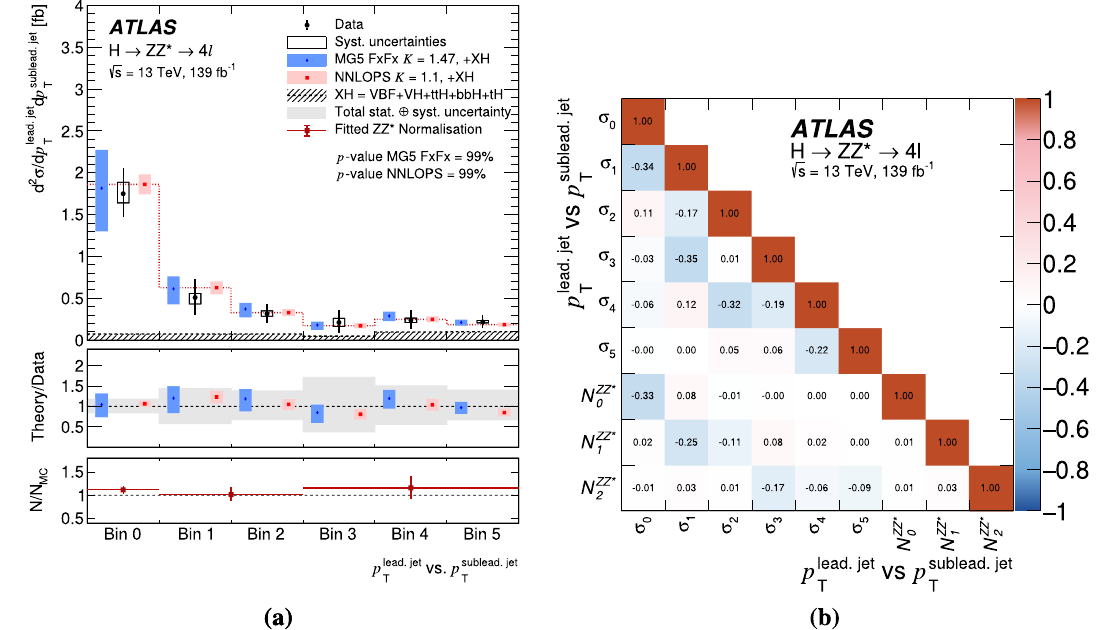
b thecorrespondingcorrelationmatrixbetweenthemeasuredcrosssec- . jet . jet tions and the Z Z ∗ background normalisation factor. The bin boundaries vs. p sublead , and T T are defined in Fig.